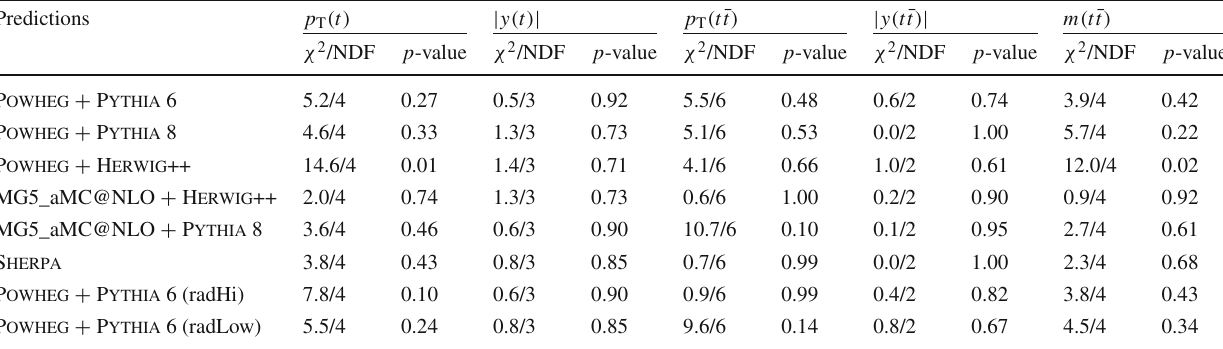
Table 5 χ 2 values between the normalised unfolded fiducial cross-section and various predictions from the MC simulation. The number of degrees of freedom (NDF) is equal to one less than the number of bins in the distribution. Powheg refers to Powheg -Box v2